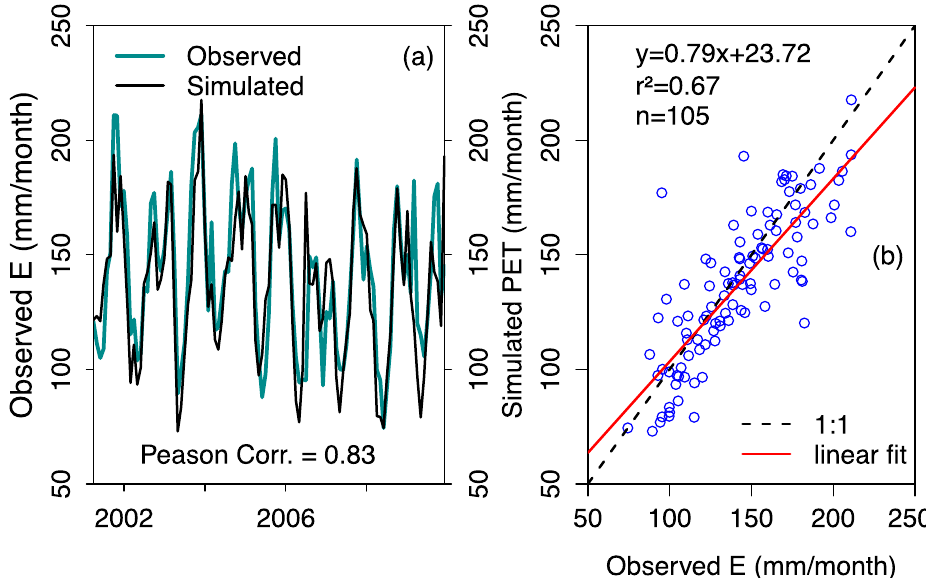
Figure 8. ( a ) Simulated and observed Evapotranspiration distribution pattern for the validation period (2002–2006); ( b ) Scatter plot displaying a relationship between simulated actual ET and observed